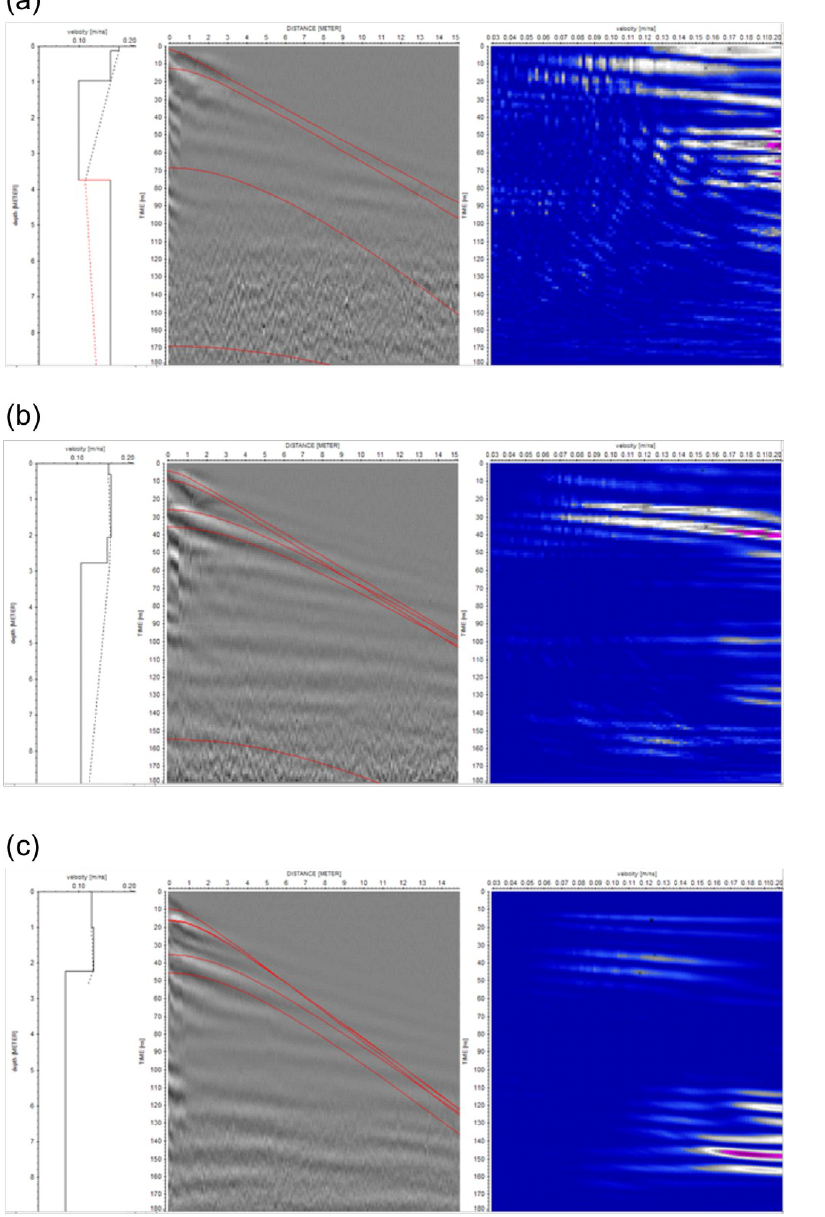
Figure 3. Data and results of the three CMP, on the left side the velocity, the field data on central side, and the processing on right side. (a) First CMP; (b) second CMP; (c) third